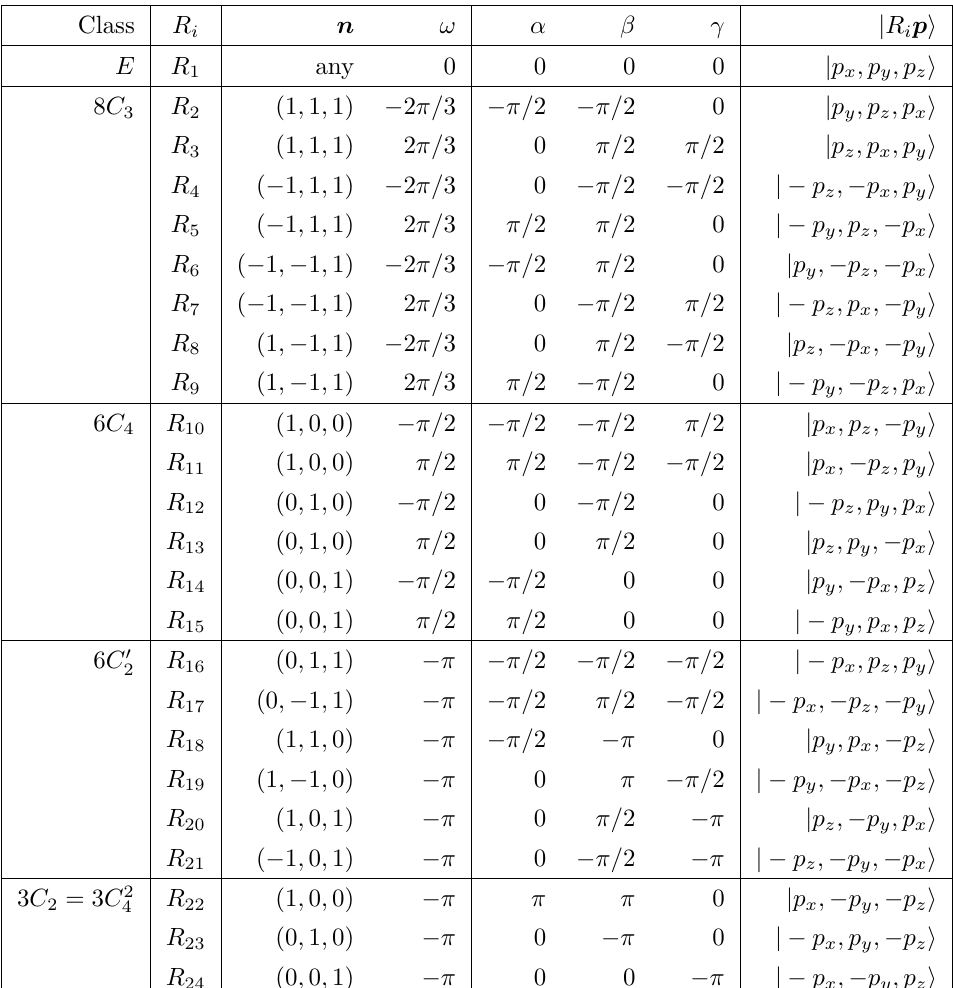
Table 5 . Elements and conjugacy classes of the O group. The rotations are parametrized by the rotation axis n and angle ω or by the Euler angles α, β, γ .